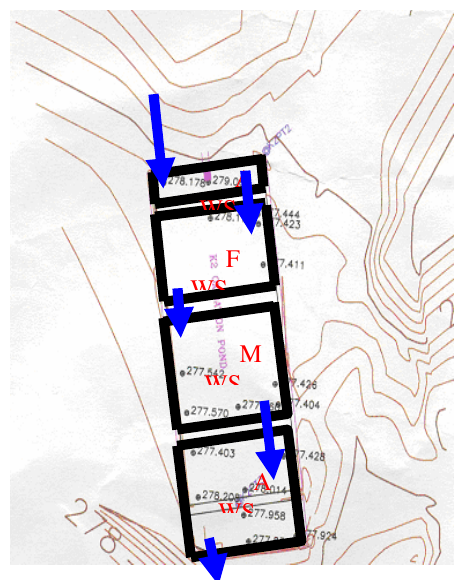
Figure 5: Layout of the K2 pond with AFM